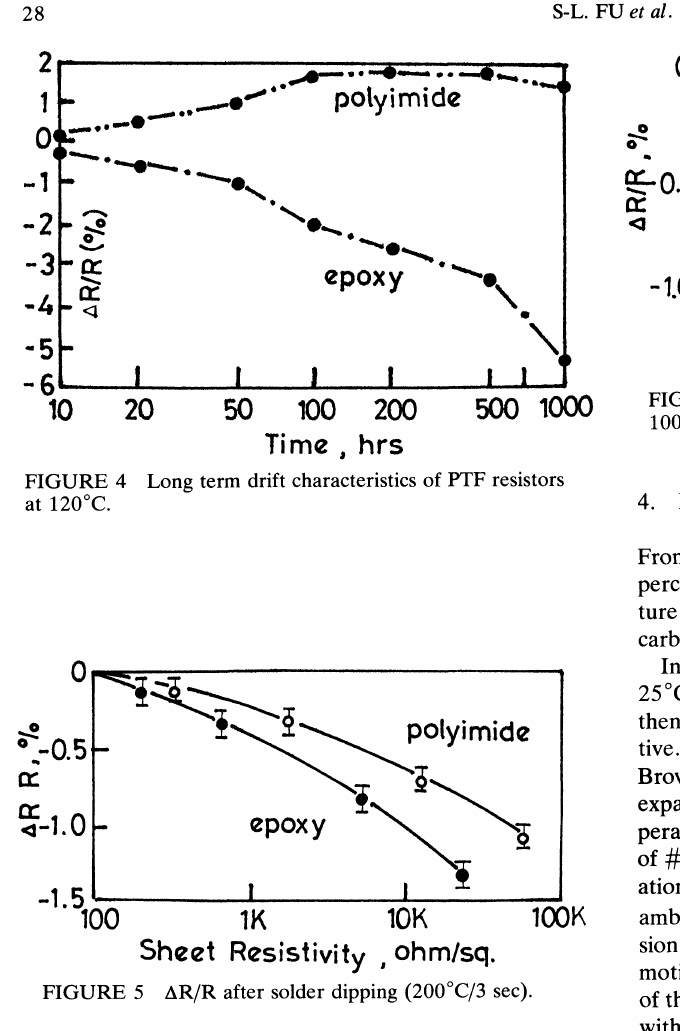
FIGURE 5 zR/R after solder dipping (200C/3 sec).